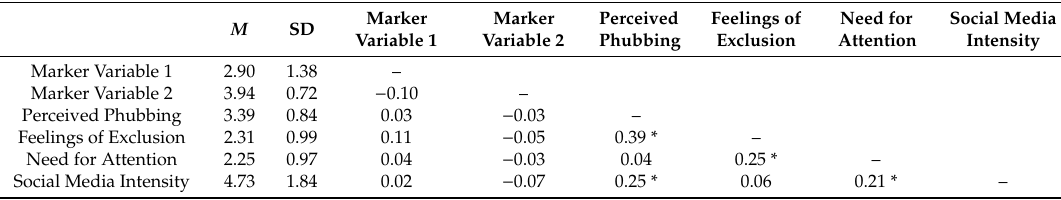
Table 3. Means, Standard Deviations, and Correlation Coe ffi